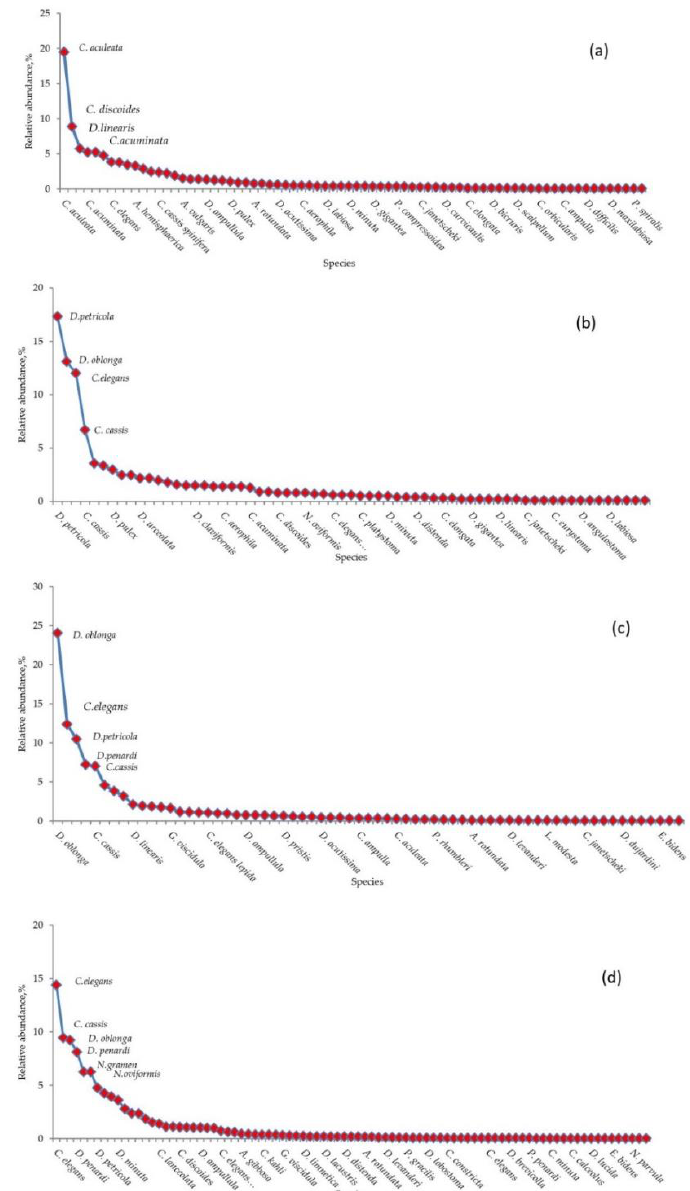
Figure 5. Dominance curve of the littoral assemblage ( a ), the sublittoral assemblage ( b ), the bottom slope assemblage ( c ), and the profundal assemblage ( d ). Table 2. Indicator species of four assemblages along the sampling depth gradient.